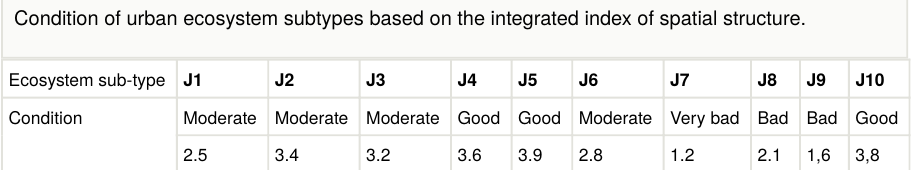
the country representing a large capital city (So fi a), a large city (Varna), a medium size city (Pleven) and a small city (Karlovo). There are some similarities and di ff erences in the ecosystem condition pattern in the di ff erent cities. All of them have a mixture of ecosystems with moderate and low condition in their central parts. The large cities have a well formed periphery of good condition ecosystems which is located in one or two directions from the city centre (south – southwest in So fi a, north – northeast in Varna). In the medium size city (Pleven), this periphery is not so clear while, in the small one (Karlovo), it is not present. Ecosystems in good condition are generally rare but, in So fi a, they are more and evenly distributed than in the other cities, while in Varna, they are almost absent.